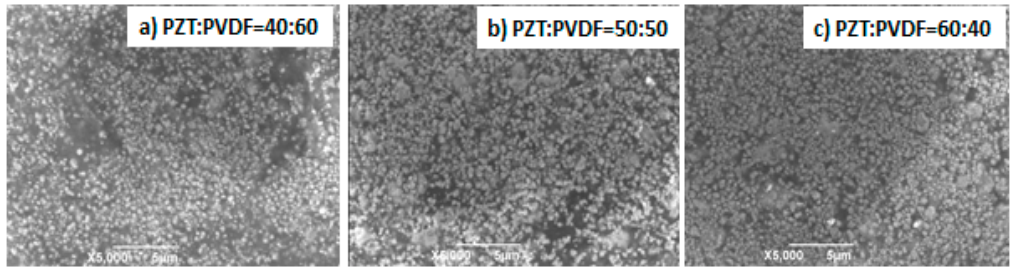
Figure 3. ( a ) The SEM images of the PZT/PVDF (40:60); ( b ) The SEM images of the PZT/PVDF (50:50); ( c ) The SEM images of the PZT/PVDF (60:40).